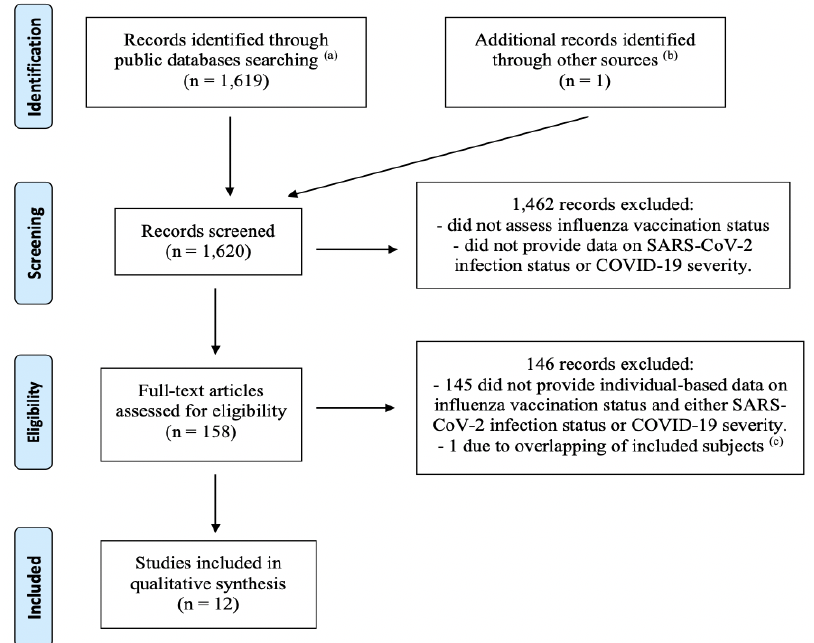
Figure 1. Flow-chart of the literature review (up to 31 August 2020) of studies investigating the association between influenza vaccination status and either the risk of being infected with the SARS-CoV-2 virus, or the risk of severe illness or death among COVID-19 patients. (a) MEDLINE, Embase, MedRxiv. (b) Reference list of records found through public databases. (c) The study by Santos et al. [5] was excluded due to probable overlap of the study population with the article by Fink et al. [6]. Both studies were based on data from hospitalizations for COVID-19 patients in Brazil registered in a national surveillance system. The study by Santos et al. was less recent and based on a smaller population, and examined fewer outcomes, compared to Fink et al., and, unlike the latter, performed no statistical adjustments.